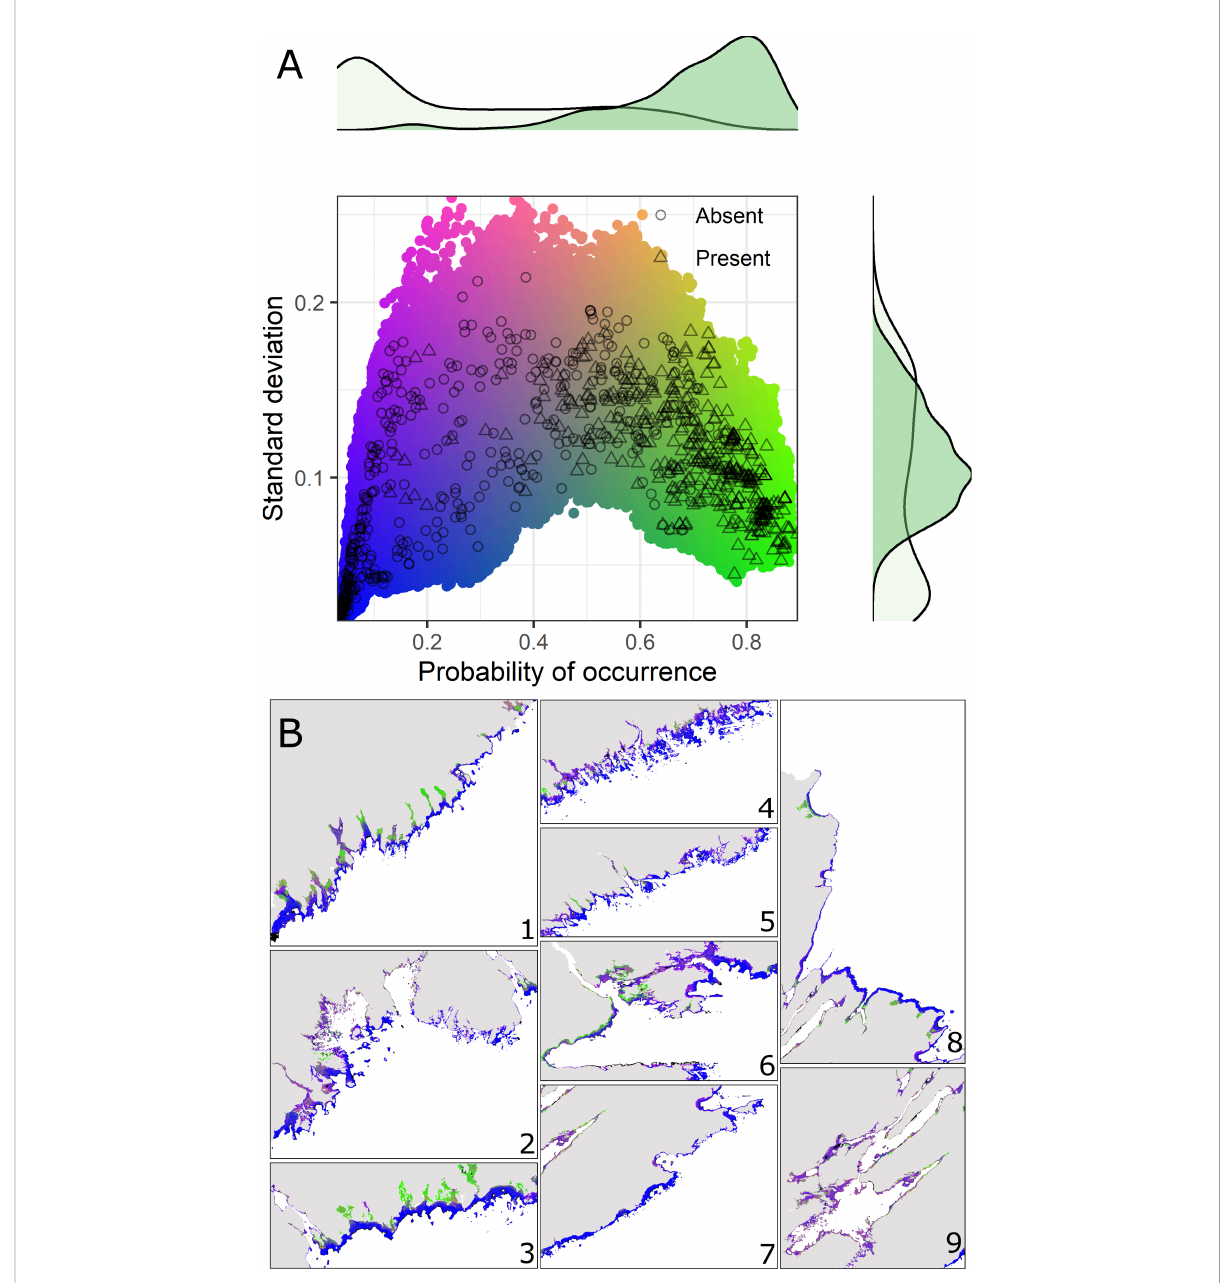
FIGURE 3 Contemporaneous display of predicted mean probability of occurrence and associated uncertainty (SD) from the ensemble eelgrass model across 5 cross-validation runs. (A) Combined color scale providing interpretation of pixel hue in map insets. Green hues indicate high probability, low uncertainty. Blue hues indicate low probability, low uncertainty. Coloured points identify unique combinations of uncertainty (SD) and probability of occurrence predicted by the ensemble model across the study area extent. Open black symbols indicate predicted values at the locations of eelgrass occurrence records (circle = absence, triangle = presence). Standard deviation of ensemble predictions combines cross-validation uncertainty (i.e., variation across CV runs) and methodological uncertainty (i.e., variation across modeling methods). Marginal density plots show the distribution of predicted probabilities and standard deviation at occurrence record locations (light green = absence, dark green = presence). (B) Model predictions across the study area (35-m nominal resolution) shown with higher detail within particular areas of the coastline (numbered insets) bounded by the extent of nine physiographic coastline classes (see Figure 1 for names and locations of coastline classes corresponding with numbered insets). Areas of extrapolation (i.e., predictors outside range of calibration data) are masked out on maps (black